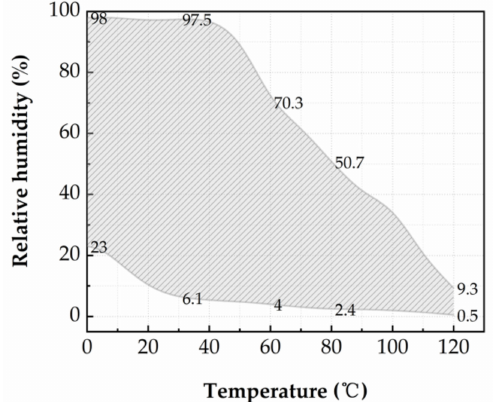
Figure 10. Relative humidity tuning characteristics in the test chamber as a function of